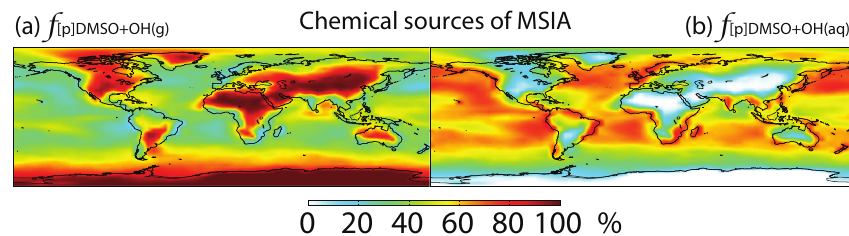
Figure 6. Global tropospheric distribution of annual-mean percentage of MSIA produced in the troposphere via (a) DMSO + OH ( g ) ( f [ p ] DMSO + OH ) and (b) DMSO + OH ( aq ) ( f [ p ] DMSO + OH ( g )